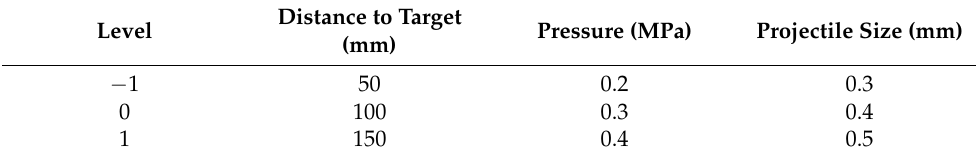
Table 2. Factor levels for the